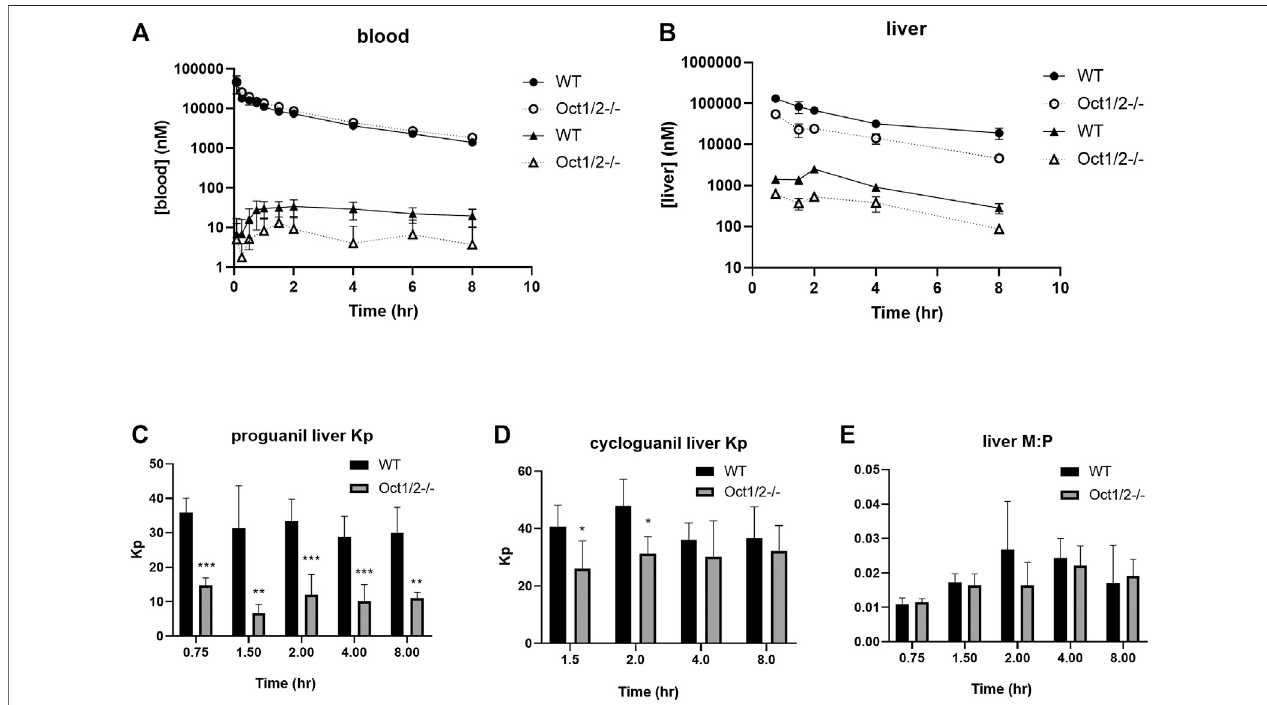
FIGURE3|Pharmacokineticsofproguanil/cycloguanilinwildtype(WT)andOct1/2 − / − micefollowingIVadministrationofproguanil. Shownaredose- normalized blood (A) and liver (B) concentrations for mice ( n (cid:2) 5 or 5/timepoint) administered proguanil 2, 10 or 30 mg/kg. Filled symbols represent wildtype mice and opensymbolsrepresentknockoutmice.Circlesrepresentconcentrationsofproguanilandtrianglesrepresentconcentrationsofcycloguanil (C and D,E) LiverKpandM: P values determined from tissues collected at 0.75 and 2 h (2 mg/kg), 1.5 and 4 h (10 mg/kg) or 8 h (30 mg/kg) post-dose. Data presented as mean ± SD. * p < 0.05 using student's t-test, compared to WT. ** p < 0.01 using student ’ s t-test, compared to WT. *** p < 0.001 using student ’ s t-test, compared to WT. Kp (cid:2) tissue: plasma partition coef fi cient. M:P (cid:2) metabolite:parent